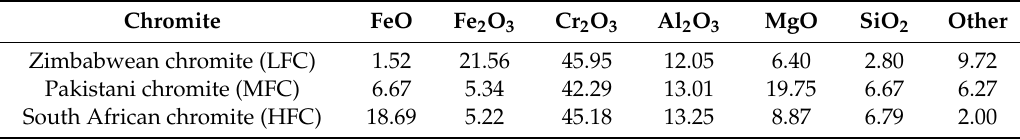
Table 1. Chemical composition (dry wt.%) of